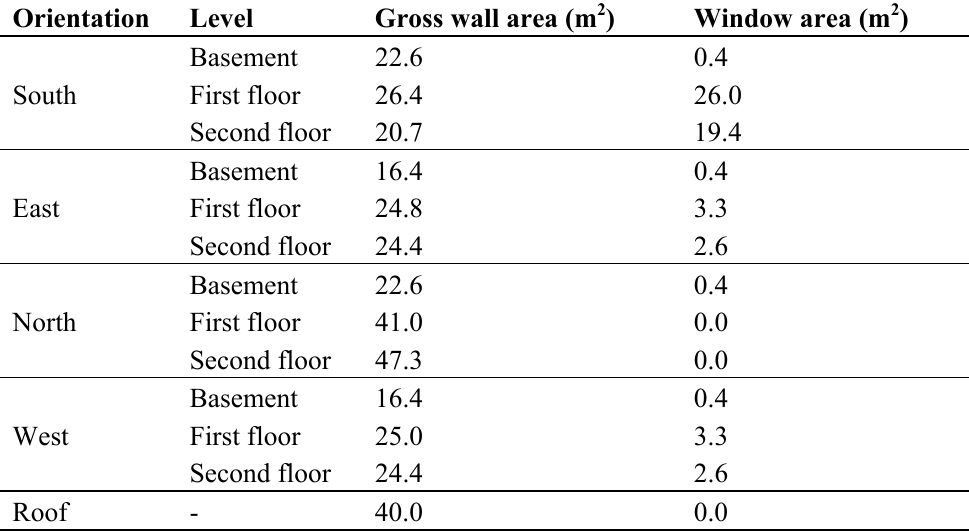
Table 1. Surface area of walls, roof and